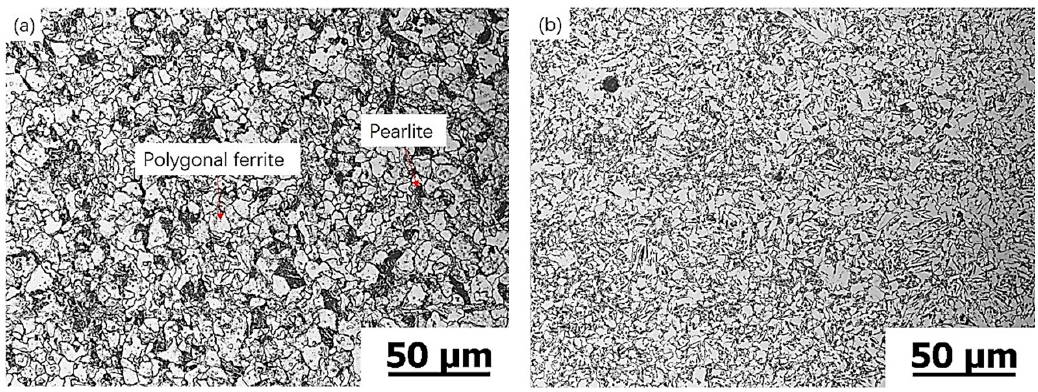
Figure 13. Forty-millimetre plate microstructure of industrial test steel: ( a ) rolling state; and ( b ) HAZ.